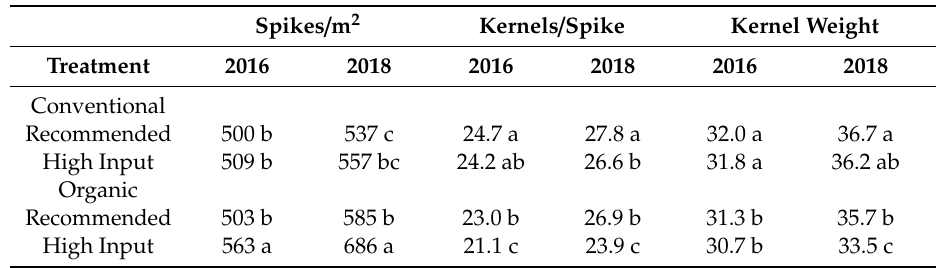
Table 5. Spikes / m 2 at harvest, kernels / spike, and kernel weight of wheat in 2015–2016 and 2017–2018 under conventional and organic cropping systems at recommended and high input management at a University Research Farm in central New York, USA. Spikes / m